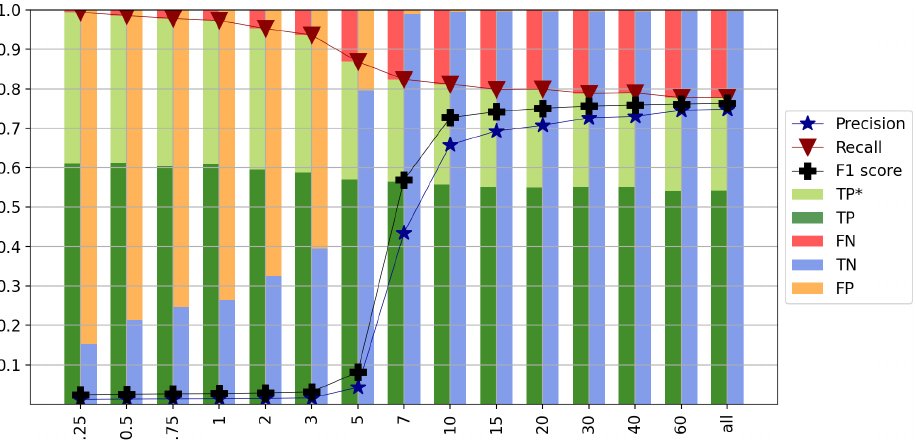
Figure 15. Classification result for testing stations for different class distributions. The x-label shows the ratio between chunks without discontinuities and with discontinuities. Thus, a value of ten indicates that there are ten times more chunks without discontinuities than with discontinuities. A more detailed description of the figure content and acronyms are presented in the captions of Figures 4 and